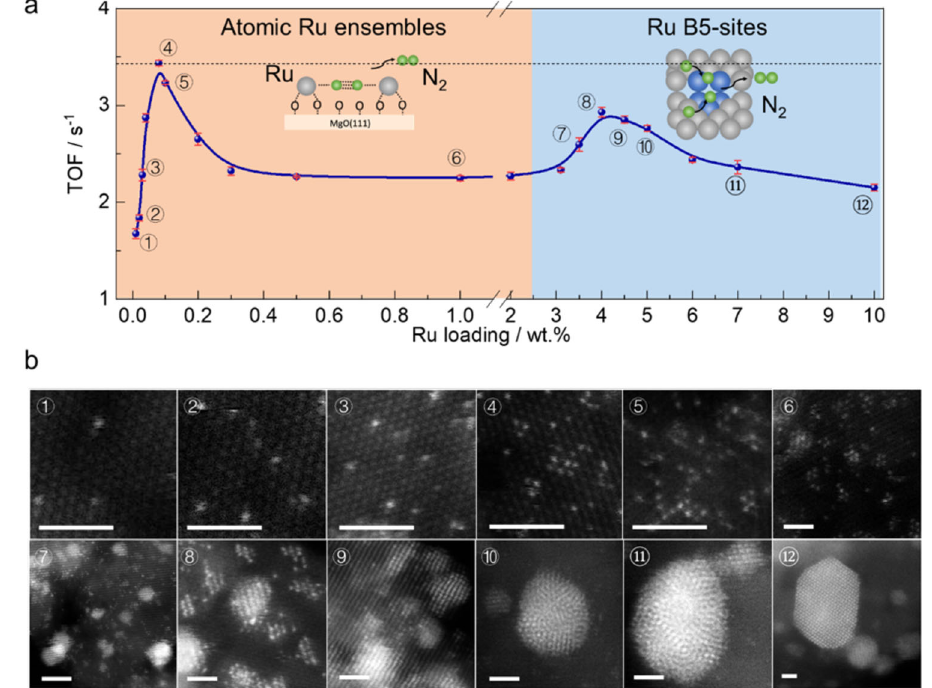
Fig. 5 | Loading effect of Ru from atomic form to cluster/nanoparticle on MgO(111). a The TOF values with error bars for ammonia decomposition as a function of Ru loading at 400°C; the error bars in the fi gure represents standard